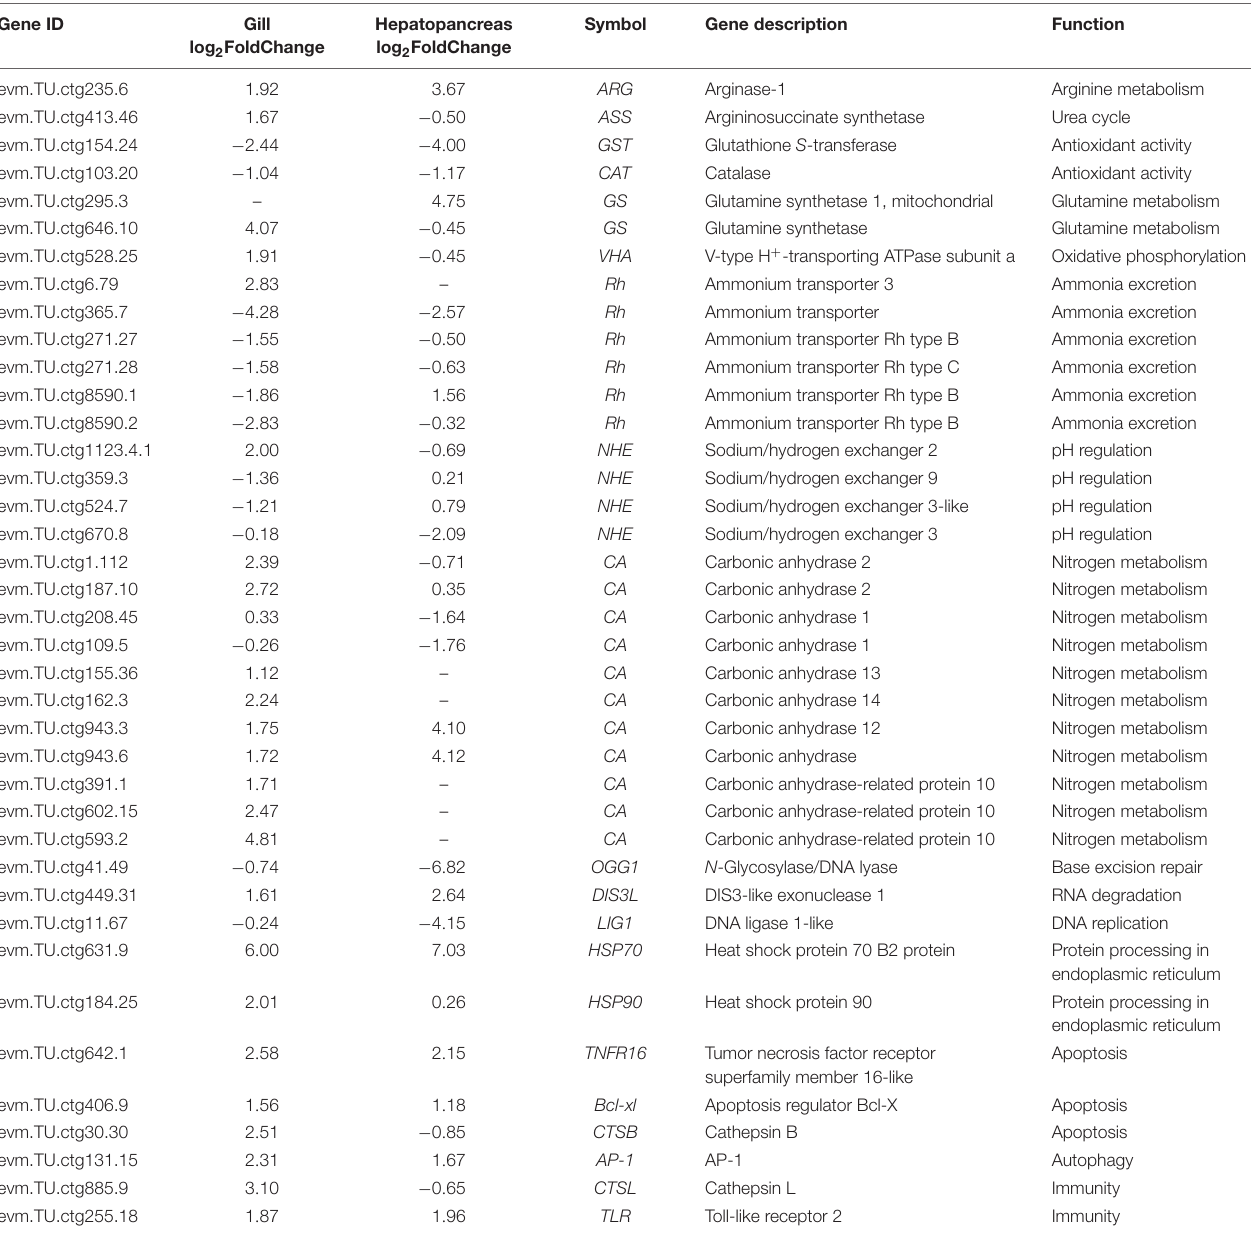
TABLE 5 | List of DEGs of the gill and hepatopancreas involved in responding to ammonia stress in S . constricta . Gene ID Gill Hepatopancreas Symbol Gene description log 2 FoldChange log 2 FoldChange